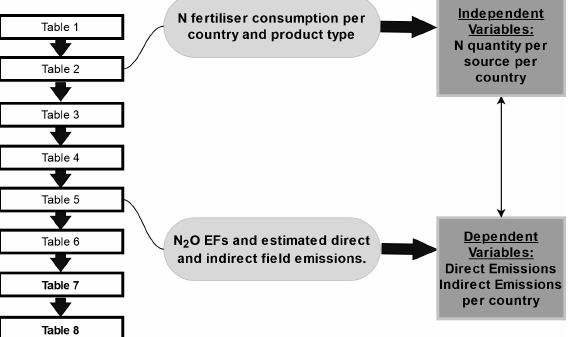
Figure 3. Data extraction and retrieving process from the source